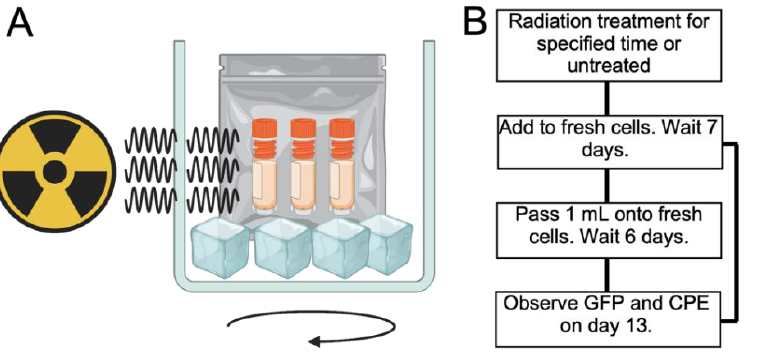
Figure 2. Schematic showing arrangement of tubes in gamma radiator and workflow. ( A ) Tubes containing virus infected cell lysates or culture supernatants containing virus were sealed in plastic bags containing 10% Microchem Plus and frozen on dry ice. The samples were placed in a cylindrical container which was placed on a rotating platform. Three radiation sources were present to provide even coverage of samples. ( B ) Schematic showing approach used. After tubes were irradiated with the desired dose, they were returned to the high containment laboratory and added to flasks of fresh cells. These were incubated for 7 days and then passed onto fresh cells or allowed to further incubate for up to 13 days.